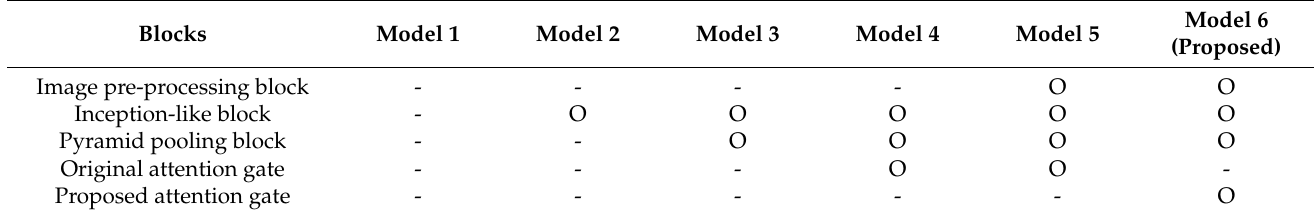
Table 4. Description of ablation